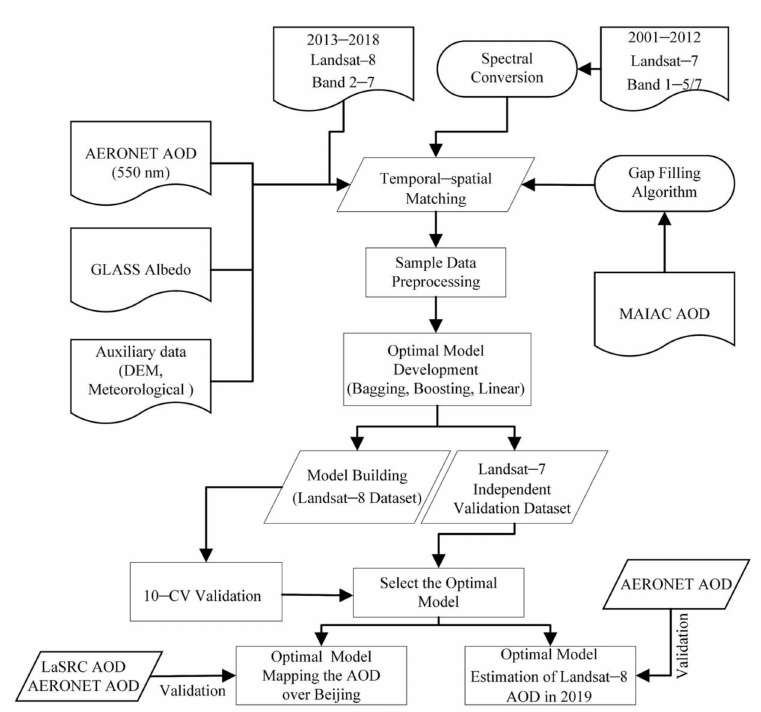
Figure 2. Flowchart of the methodology applied in this